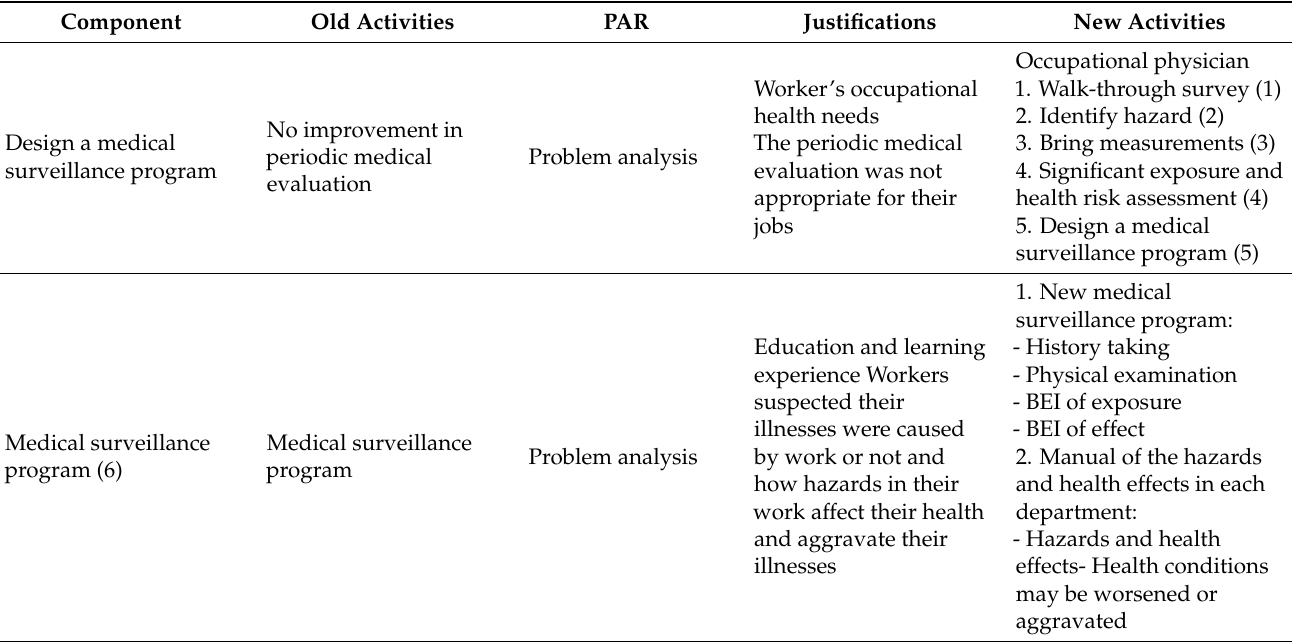
Table 13. Medical surveillance model